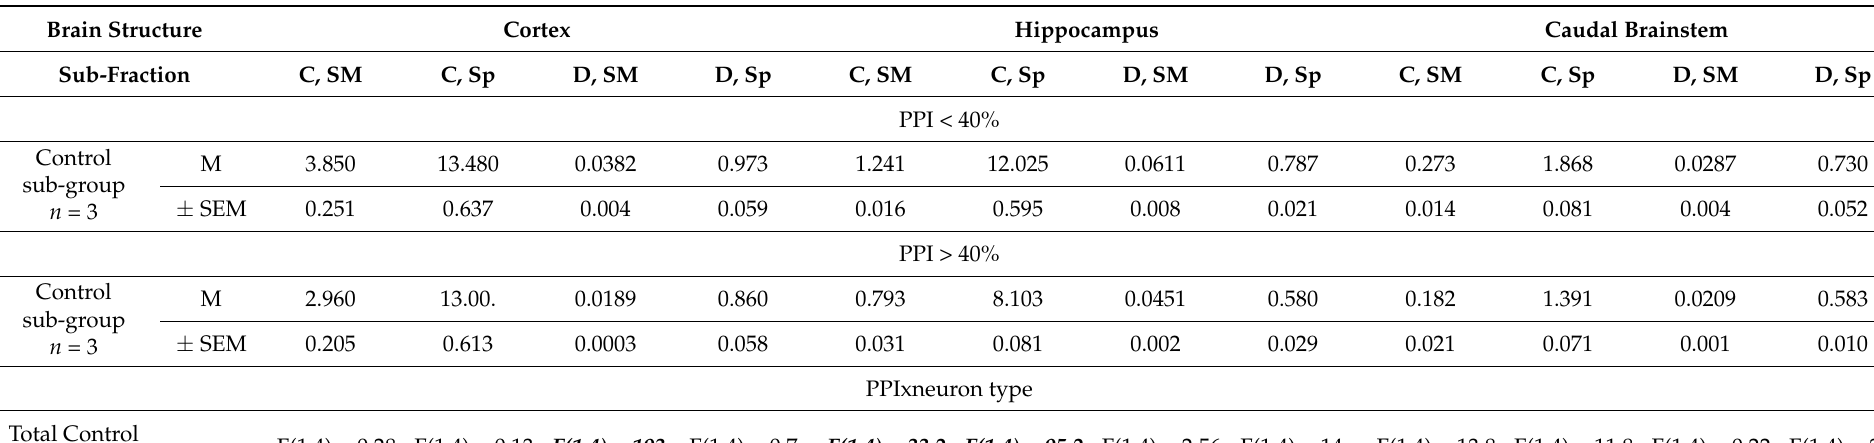
Table 3. ChAT activity values in the control sub-groups of rats with PPI < and > 40% and the interaction of PPI with neuron type in the total control group in different brain structures and sub-fractions (ANOVA